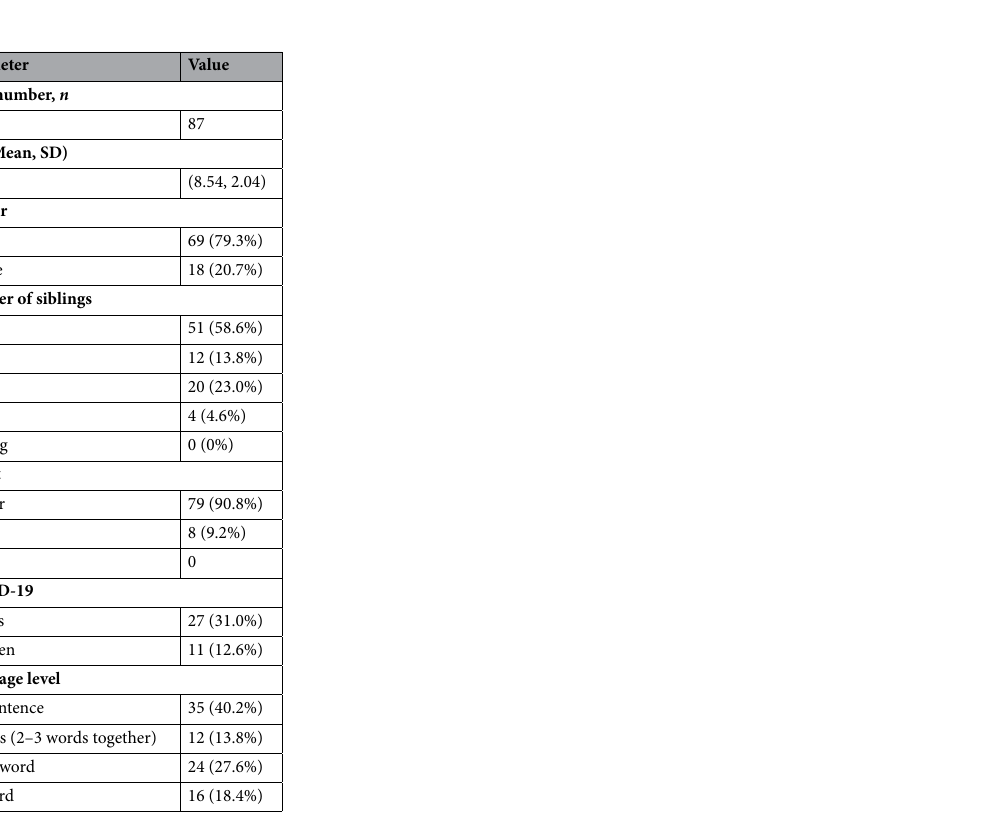
Table 1. Demographic and clinical data of CBCL participants (n =